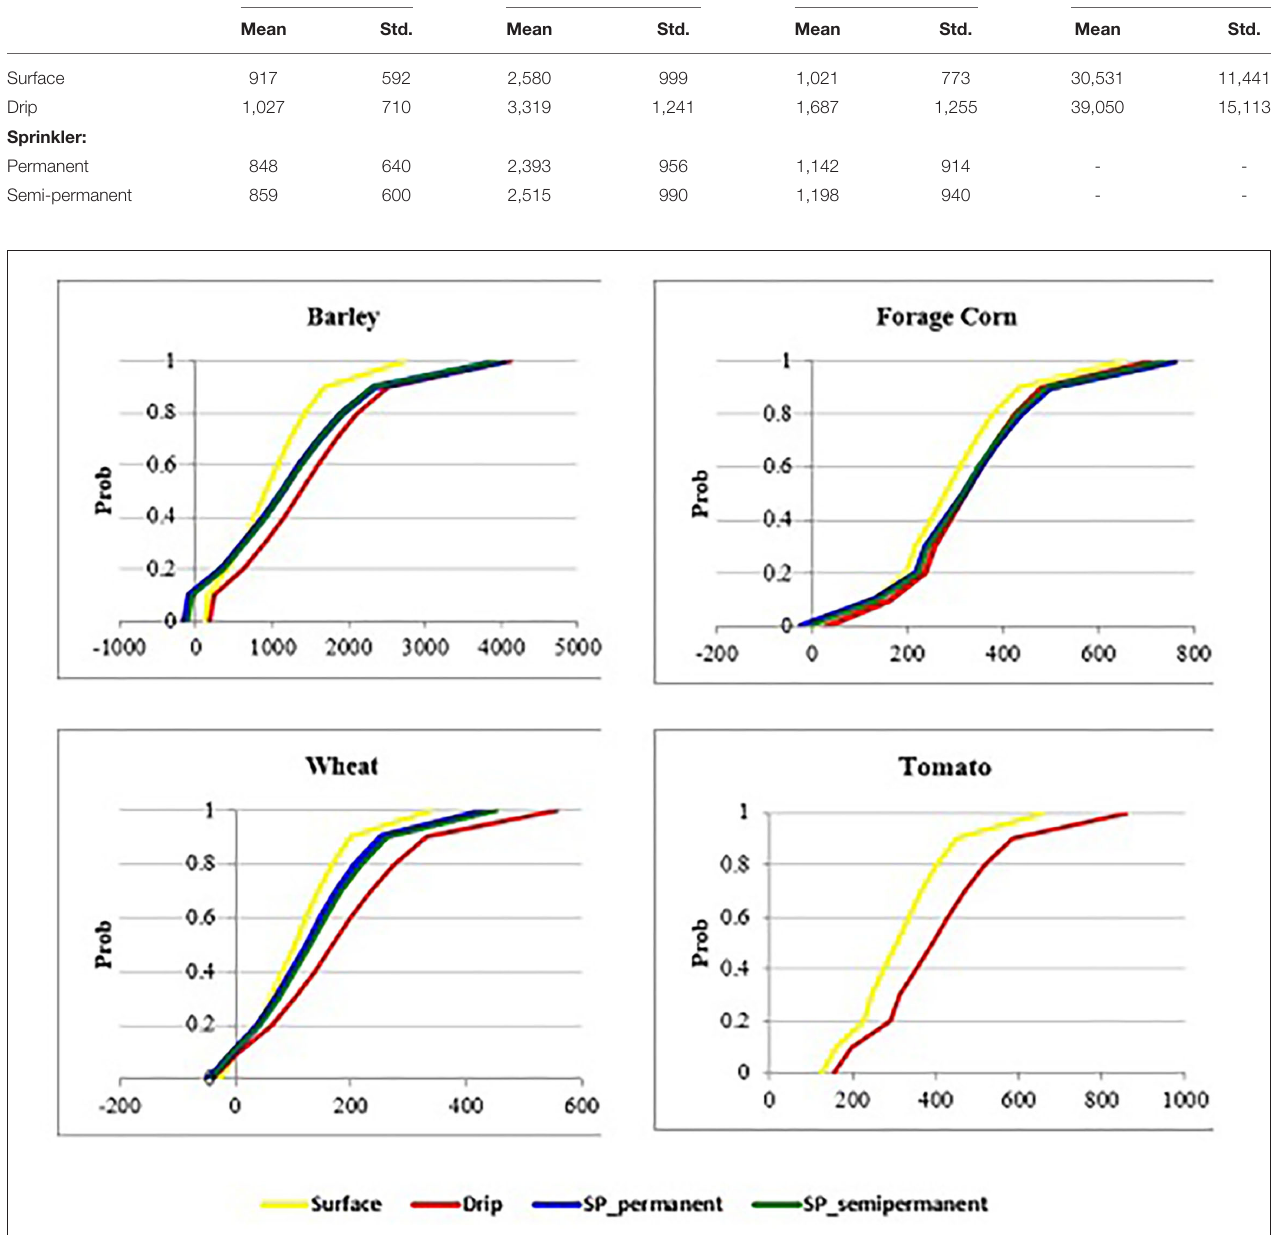
FIGURE 3 | Cumulative distribution function of irrigation systems of Barley, Forage corn, Wheat, and Tomato.